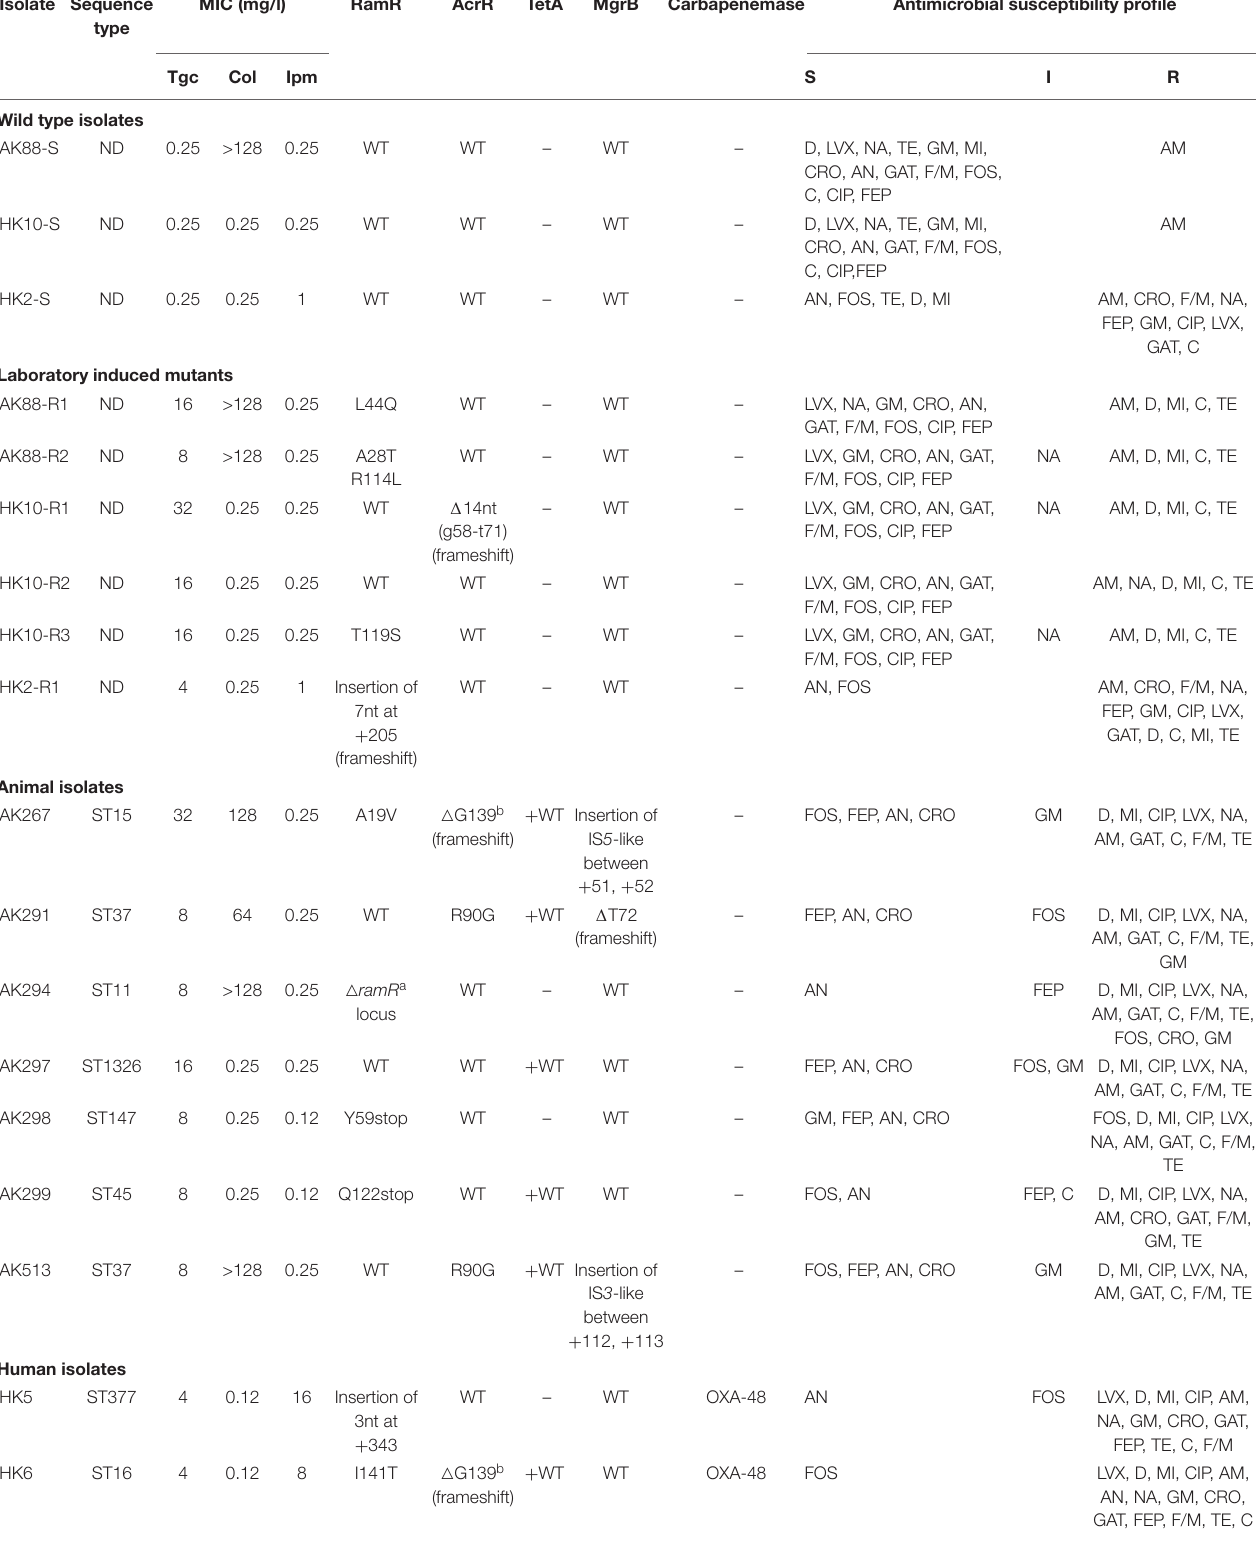
TABLE 2 | Genotypic and phenotypic characteristics of tigecycline susceptible and non-susceptible K. pneumoniae isolates obtained from human, food animals, and in vitro selection assay. Isolate Sequence MIC type